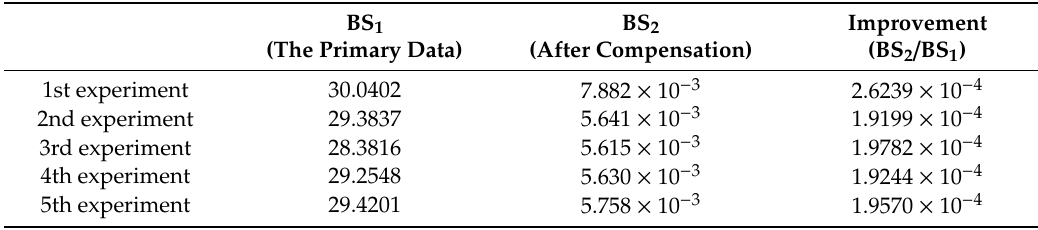
Table 2. Bias stabilities before and after